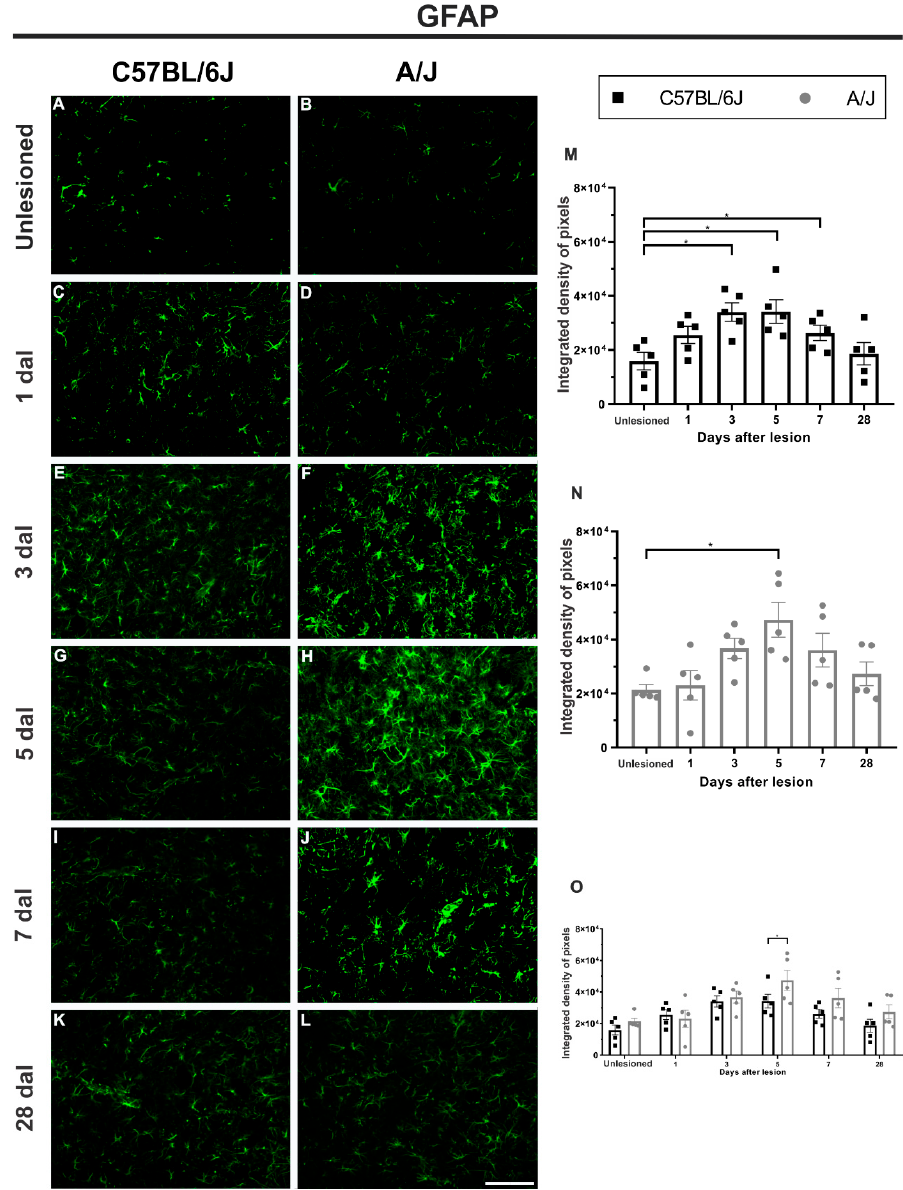
Figure 6. Reactive astrogliosis (GFAP immunostaining) increased over time in C57BL/6J and A/J mice after sciatic nerve crush, displaying an equivalent peak between strains at 5 days, but